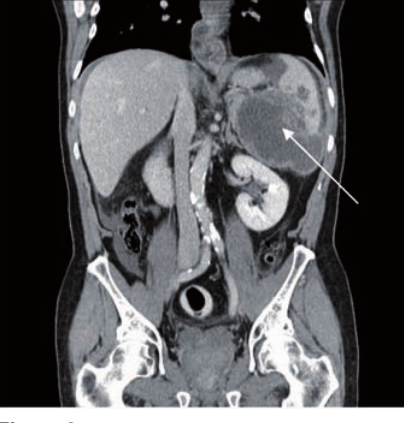
Figure 2 The same splenic lesion (arrow) as in fig. 1 in a frontal view.